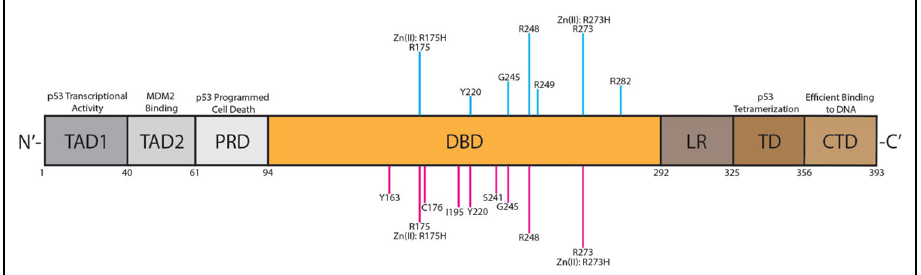
Figure 1. p53 domains (boxes) and cancer ‐ inducing p53 mutations (pink and blue lines). Numbers below domains represent the amino acid number (1–393). Blue lines above DBD represent approximate abundances of all types of cancer ‐ inducing p53 mutations. Pink lines below DBD represent approximate abundances of HGSOC ‐ inducing p53 mutations. Zn(II) binding is inhibited by R175H and R273H mutations. TAD1 and TAD2 are p53 transcriptional activation domains. TAD2 is the MDM2 ‐ binding site. PRD (PXXP residues) is associated with p53 programmed cell death. CTD is highly unstructured and assists with efficient binding of p53 to DNA [45,46,49,52,53] . TAD1, TAD2 = transactivation domains 1 and 2; PRD = proline rich domain; DBD = DNA ‐ binding domain; LR = linker region; TD = tetramerization domain; CTD = C ‐ terminal domain.